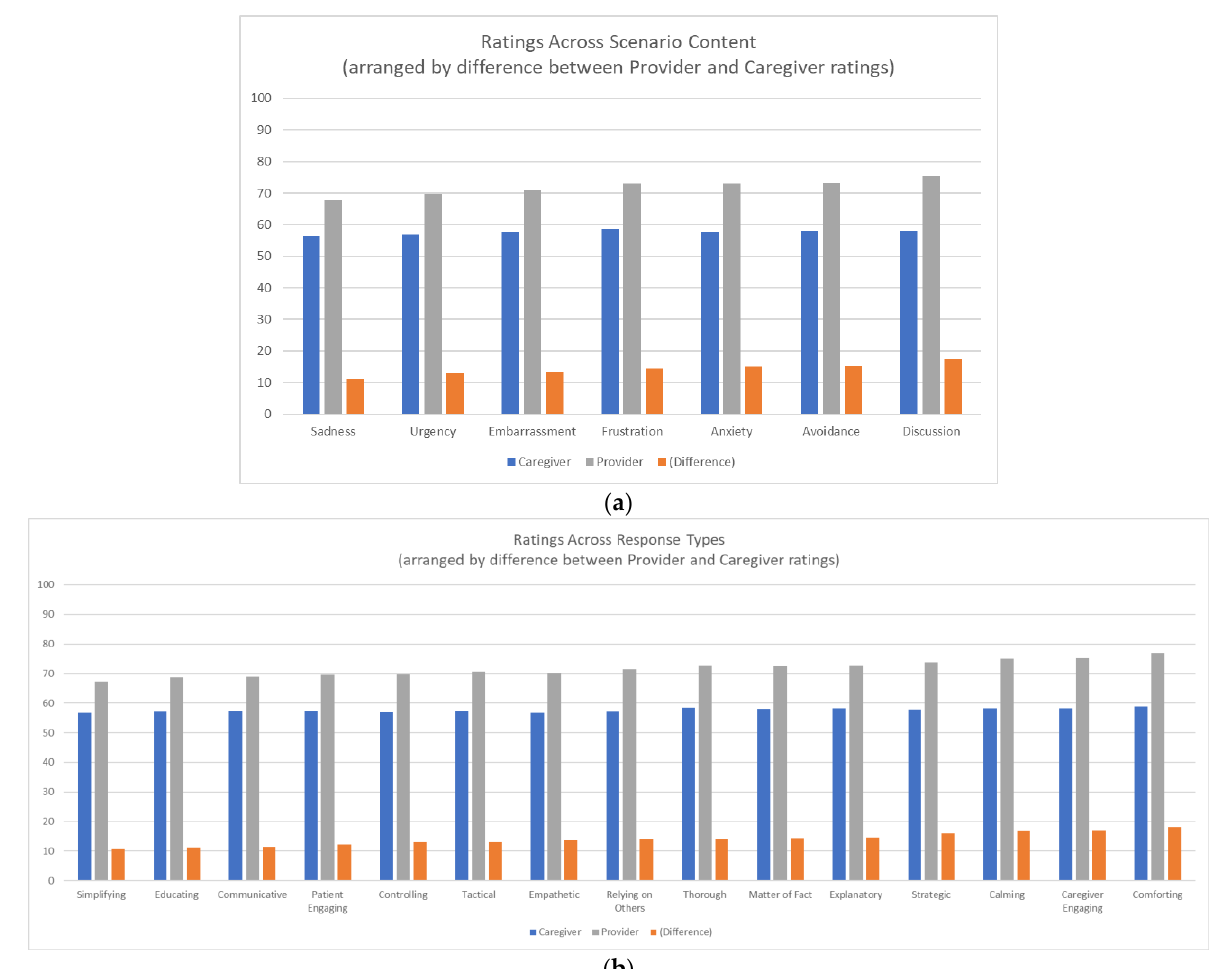
Figure 1. ( a ) Ratings for scenarios across different scenario content; ( b ) Ratings for scenarios across different response types. Note: Content and response types are arranged by the difference between HCP and caregiver ratings; all differences themselves are significant (F statistic p < 0.05).